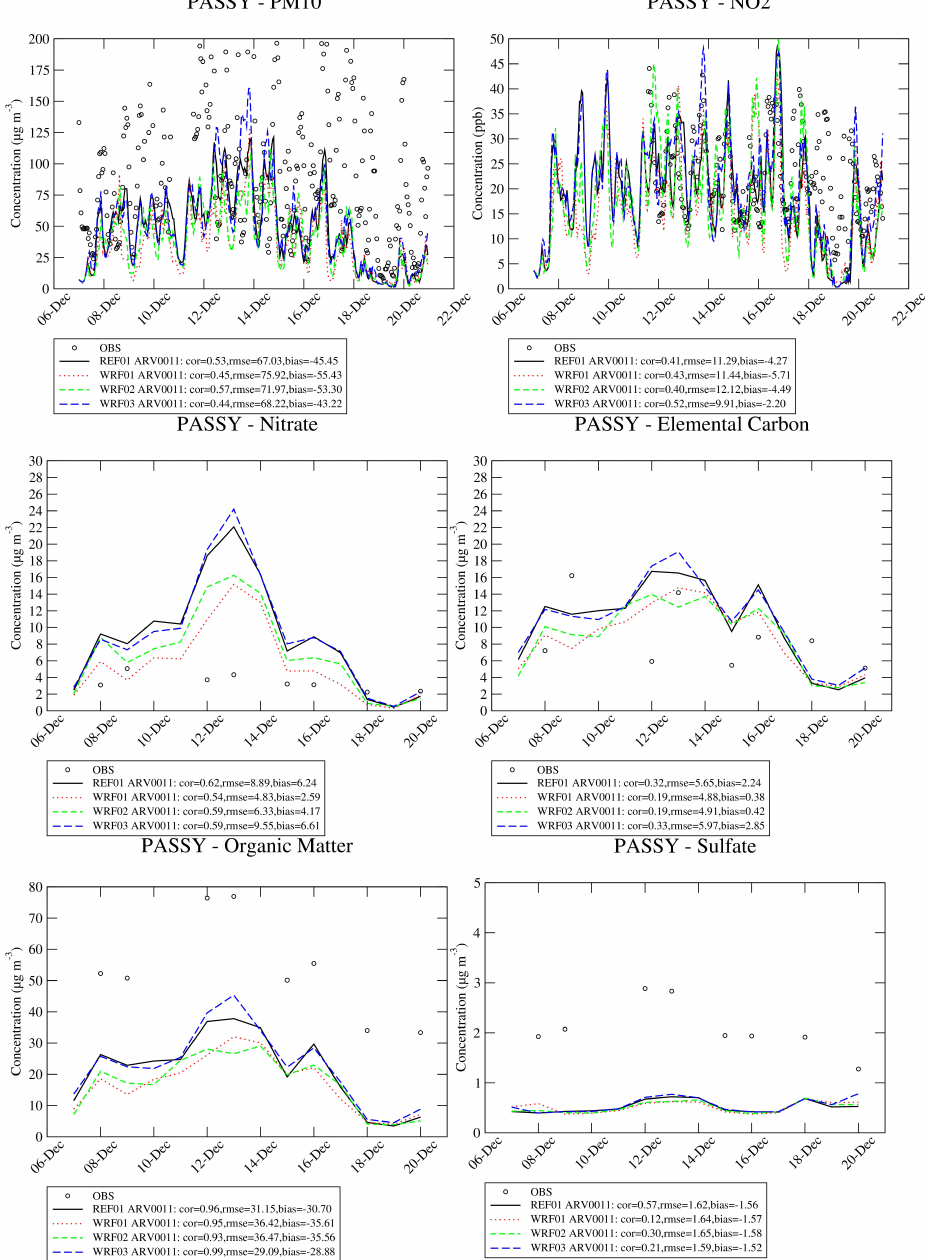
Figure 13. Impact of WRF settings on species concentrations at 1 ⁄ 90 ◦ resolution (ARV0011) for the EPII period at